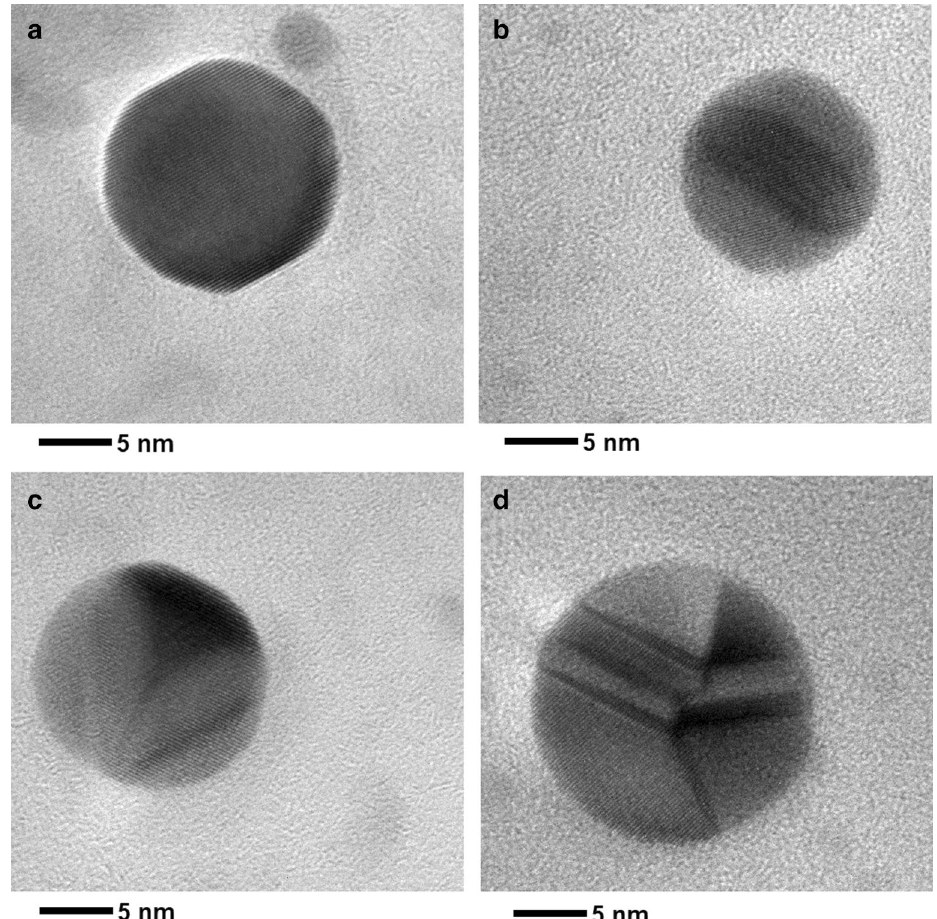
Figure 5. HR-TEM micrographs of the sub-15 nm AgNPs obtained by sonochemistry. ( a ) AgNPs with near- spherical shape, ( b , c ) twin-fault AgNPs with near-spherical shape, ( d ) twin-fault AgNPs containing parallel- twin